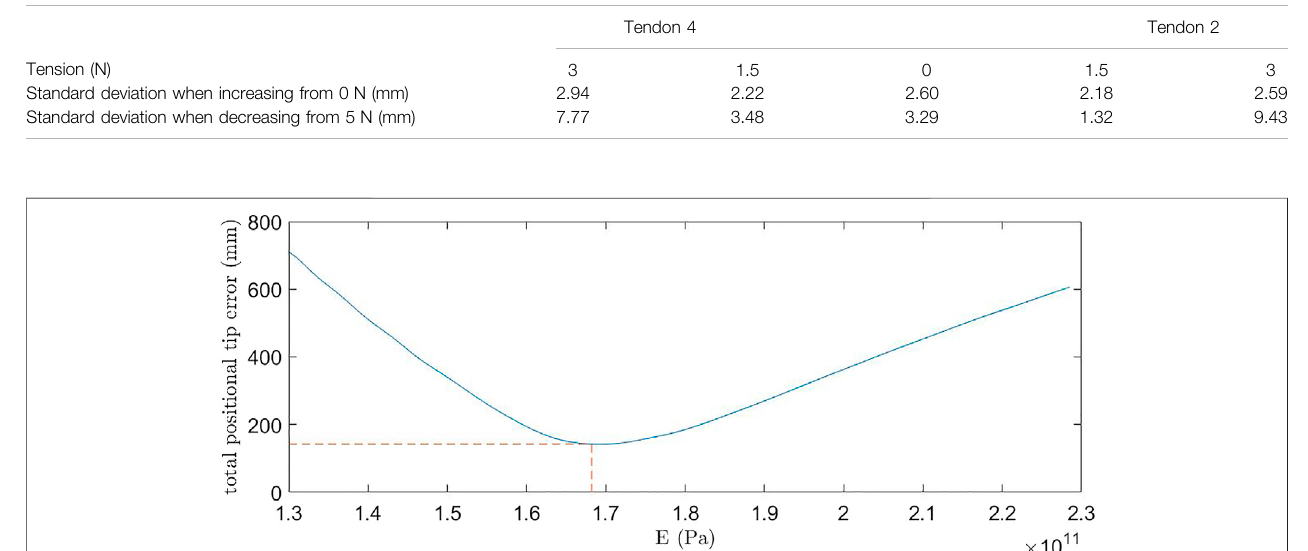
FIGURE 8 | Total positional tip error between the theoretical prediction and experimental result for increasing Young ’ s Modulus.